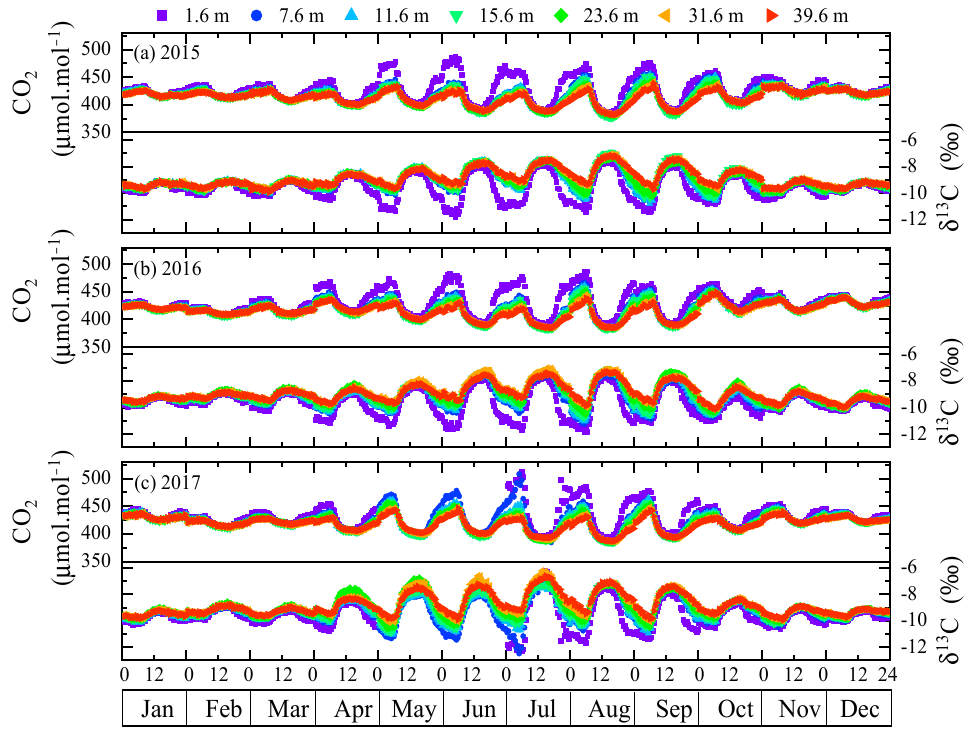
Figure 3. Monthly mean diel variations of ecosystem CO 2 and its δ 13 C below (1.6 and 7.6 m), within (11.6 and 15.6 m) and above (23.6, 31.6, and 39.6 m) the canopy (2015–2017). ( a – c ) are results of 2015, 2016, and 2017, respectively.